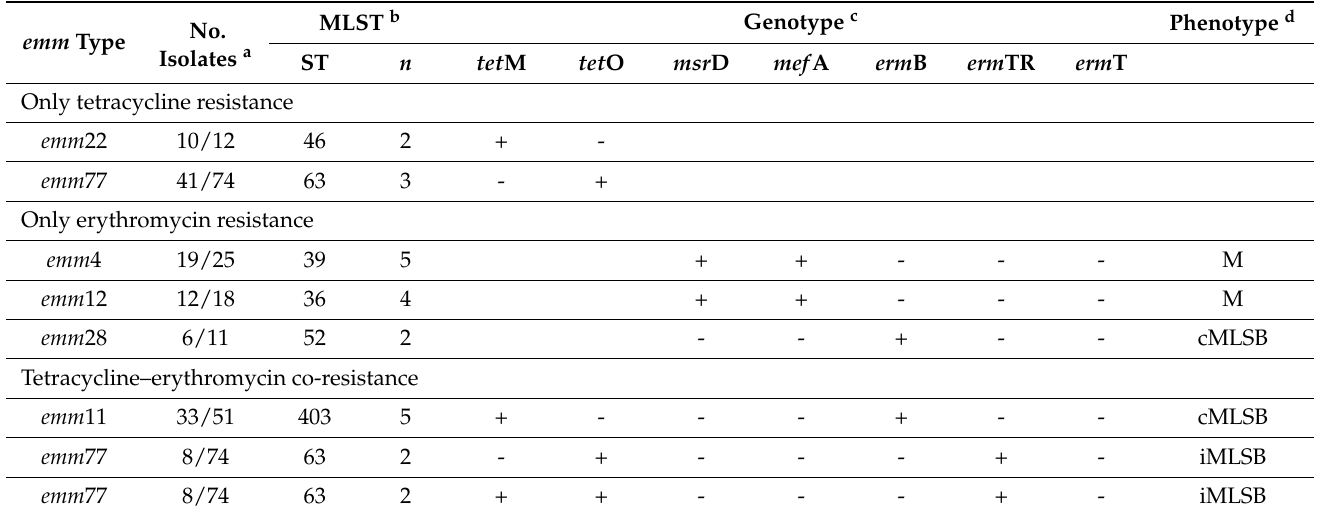
Table 2. Data of the main resistant clones of invasive Streptococcus pyogenes in Spain, 2007–2020. emm